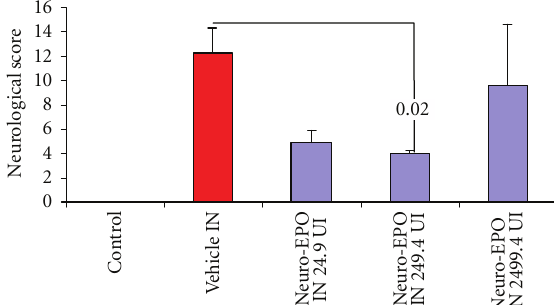
Figure 2: Clinical signs of stroke at 24h of permanent occlusion of the right common carotid in the Mongolian gerbil, evaluating di ff erent doses of the intranasal formulation of Neuro-EPO. Numbers indicate significant di ff erence between bars in the U test of Mann and Whitney in respect with vehicle. ( n = 35 per group).